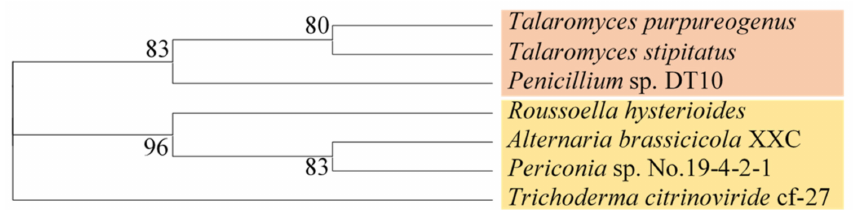
Figure 3. The evolutionary analysis tree constructed with selected fungi producing fusicoc- cane diterpenoids. The evolutionary analysis was reconstructed by the maximum likelihood method from the ITS sequences as follows: Alternaria brassicicola XXC (KR779774.1), Penicillium sp. DT10 (MH458525.1), Periconia sp. No. 19-4-2-1 (KP873157.1), Roussoella hysterioides KT1651 (KJ474829.1), Talaromyces stipitatus (MH857968.1), Talaromyces purpurogenus (MH120320.1), and Trichoderma citrinoviride cf-27 (KT259441.1). The evolutionary analysis was conducted in MEGA X (version 10.2.2)